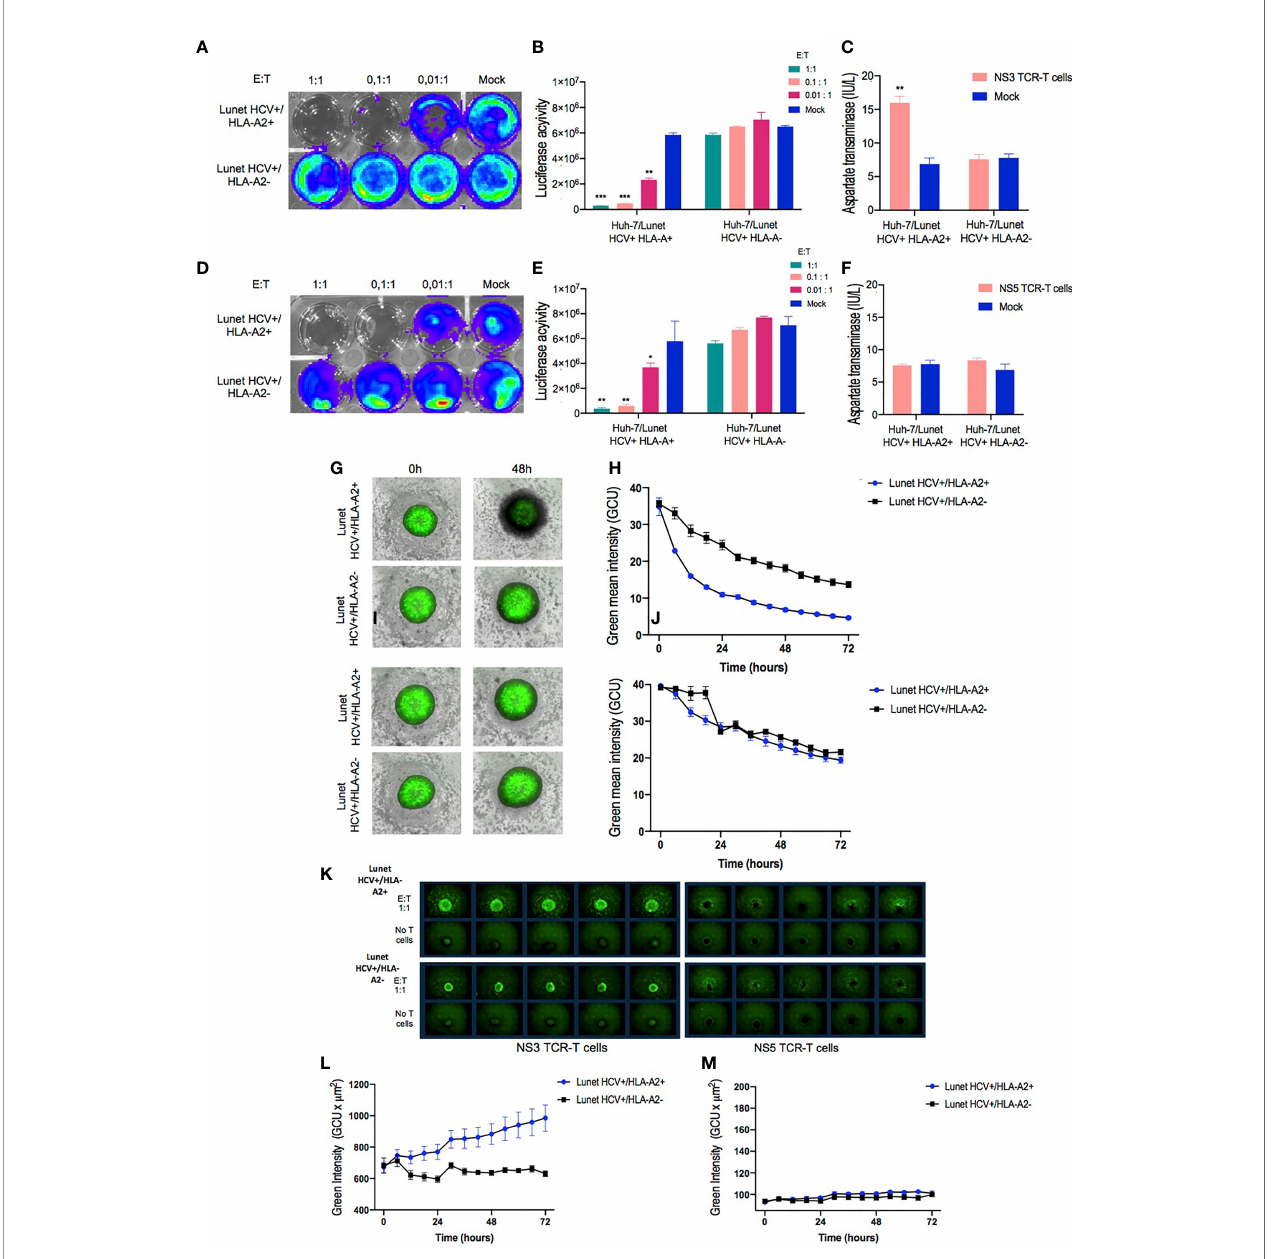
FIGURE 5 | In vitro functional validation of TCR-T cells. NS3- and NS5-speci fi c T cell receptor (TCR)-T cells demonstrate HLA-A2-restricted antiviral response against Huh-7/Lunet HCV replicon target cells in 2D cell culture model. Representative images of bioluminescence signal captured by IVIS Spectrum instrument from Huh7/Lunet HCV replicon cells after 24 h of cocultivation with NS3-speci fi c TCR-T cells (A) or NS5-speci fi c TCR-T cells (D) in the indicated E/T ratios (1:1, 0.1:1, and 0.01:1). Column bar graphs showing the Luciferase activity analyzed with Living Image Software in Huh-7/Lunet HCV+ cells cocultured with NS3-speci fi c TCR-T cells (B) or NS5-speci fi c TCR-T cells (E) . Quanti fi cation of aspartate transaminase levels in the supernatants from 24-h coculture of Huh-7/Lunet HCV replicon cells with NS3-speci fi c TCR-T cells (C) or NS5-speci fi c TCR-T cells (F) at 1:1 E/T ratio. 3D Spheroid Killing Assay was performed to assess the cytotoxicity of NS3-speci fi c TCR-T cells and NS5-speci fi c TCR-T cells. Representative images of Huh-7/Lunet HCV replicon cell spheroids stained with Calcein cell-permeant green dye following the addition of NS3-speci fi c TCR- T cells (G) or NS5-speci fi c TCR-T cells (I) at basal time (0 h) and 48 h of coincubation. (H) Graph showing the green mean intensity from viable cells in the spheroids after 72 h of coculture with NS3-speci fi c TCR-T cells or NS5-speci fi c TCR-T cells (J) analyzed by the Incucyte live imaging system. (K) Representative images of Huh-7/Lunet HCV+ cell spheroids stained with Annexin V green dye cocultured or not with te indicated NS3-speci fi c TCR-T cells or NS5-speci fi c TCR-T cells and monitored by 72 h using the Incucyte live imaging system. (L) Graph showing the green intensity measurements of Annexin V fl uorescent binding cells following the addition of NS3-speci fi c TCR-T cells or NS5-speci fi c TCR-T cells (M) monitored by 72 h Huh-7/Lunet HCV replicon cells that were not engineered to express HLA-A2 (Lunet HCV+/HLA-A2-) as well as mock non-transduced T cells were used as negative controls in 2D experiments. The results are shown as mean ± SD (*** p ≤ 0.001) for technical triplicates performed in the 2D experiments or fi ve replicates in the 3D Spheroid Killing Assay. * is p value ≤ 0.05; ** is p value ≤ 0.01; *** p ≤